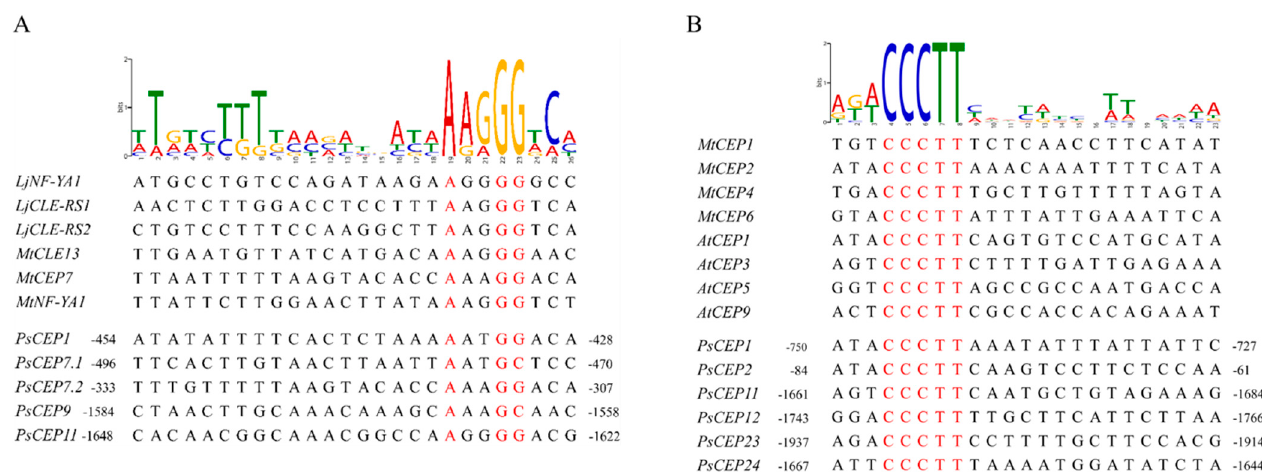
Figure 8. NIN-binding sites (according to Laffont et al. [11]) ( A ) and hNRE motifs (according to Luo et al., [15]) ( B ) identified in the promoters of the PsCEP genes.